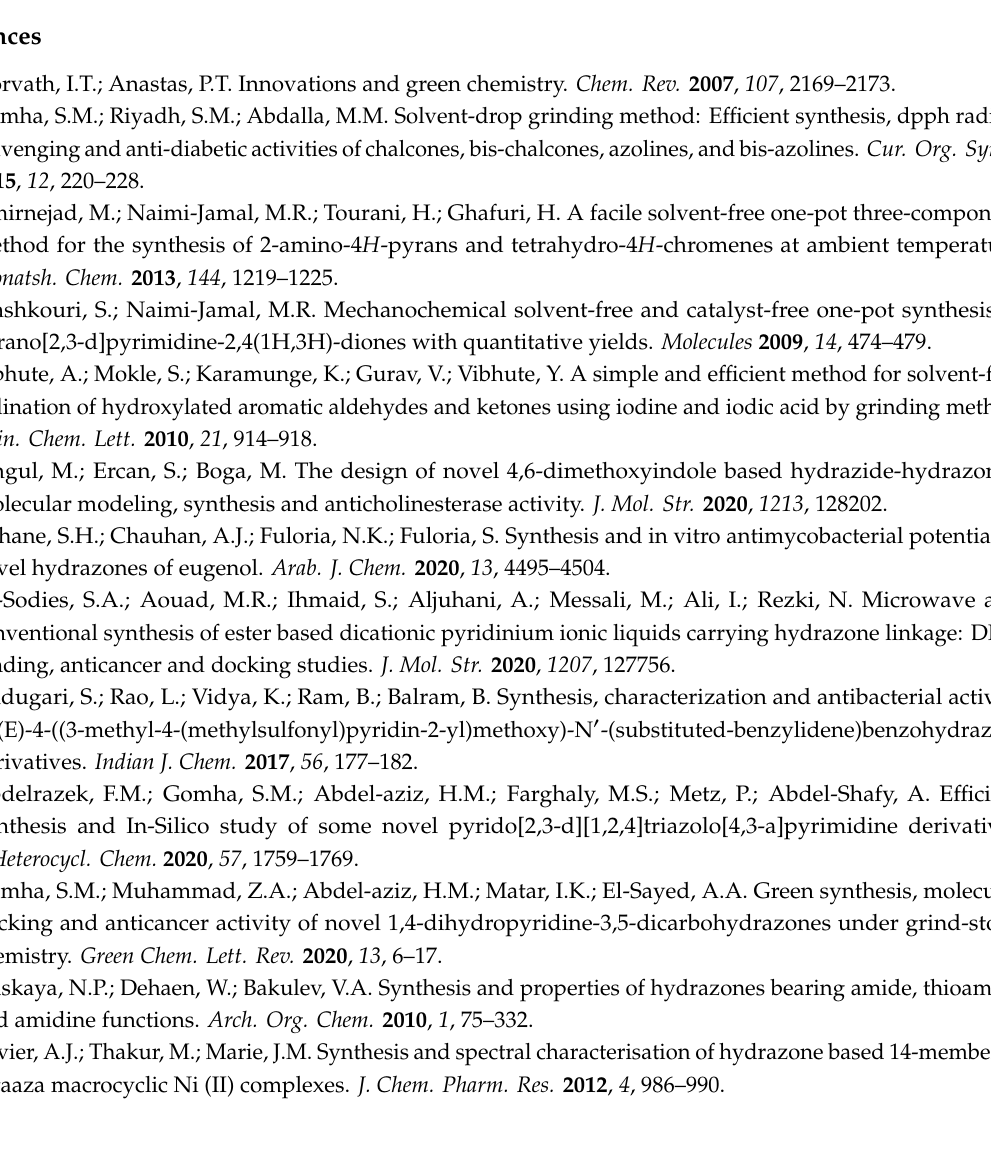
Supplementary Materials: The following are available online, Figure S1: 1 H-NMR, 13 C-NMR and Mass spectra of compound 3a , Figure S2: 1 H-NMR, 13 C-NMR and IR spectra of compound 9 , Figure S3: 1 H-NMR and IR spectra of compound 15 , Figure S4: 1 H-NMR and IR spectra of compound 23 , Figure S5: Molecular Simulations, Figure S6: Molecular Simulations